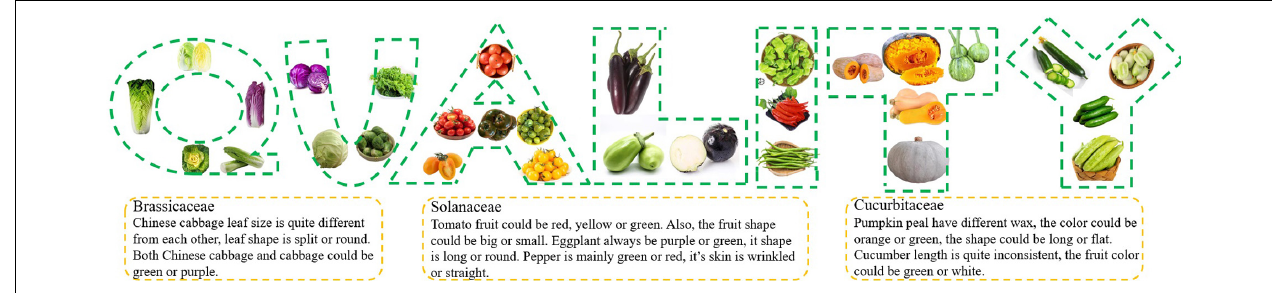
FIGURE 1 | Overview of the different vegetable commodity characteristics, with Brassicaceae , Solanaceae , and Cucurbitaceae as examples. Extensive research has been performed to optimize leaf size (e.g., split or round Chinese cabbages), leaf color (e.g., green or purple cabbages), fruit color (e.g., red, yellow or green tomatoes, purple or green eggplants, and orange or green pumpkins), fruit shape (e.g., big or small tomatoes, wrinkled or straight eggplants, and long or flat pumpkins), and fruit size (e.g., cucumbers of different lengths). Vegetables are usually optimized to meet consumer expectations for product quality, including appearance, taste, and